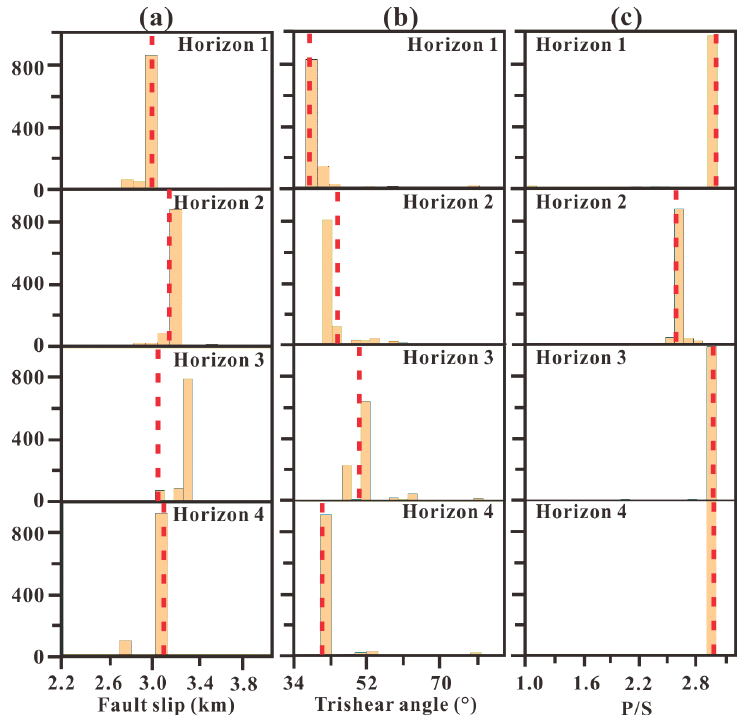
Figure 14. The inversion results of horizons 1–4 in Figure 11b show the distributions of the ( a ) Fault slip, ( b ) Trishear angle, and ( c ) P/S ratio. Red dashed lines indicate the values of best-fit parameters acquired from inverse modeling. See the text for a detailed analysis.